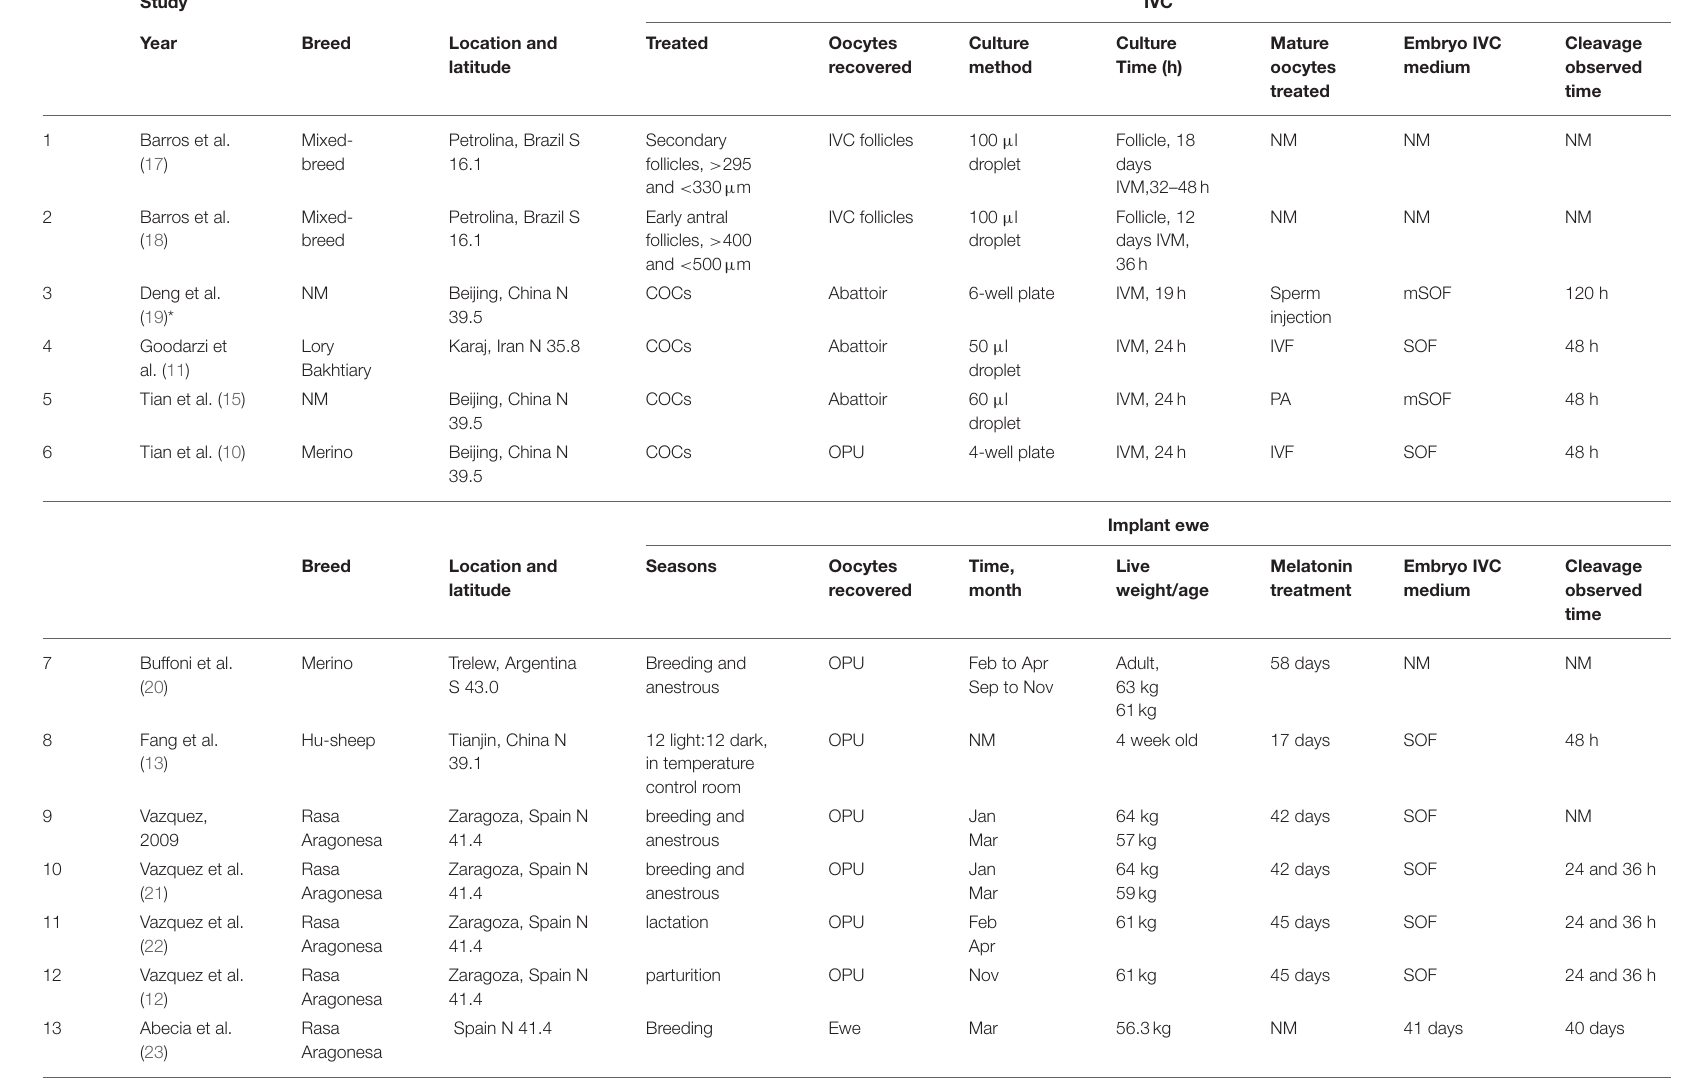
TABLE 2 | Characteristics of studies